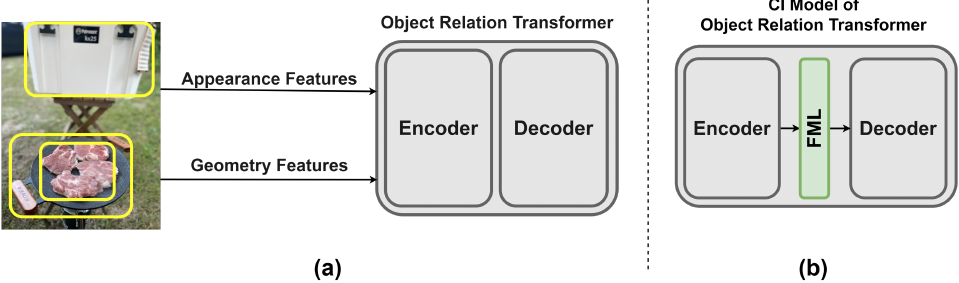
Figure 10. Object Relation Transformer (ORT) model architecture. ( a ) The ORT model devised a new encoder block to process image features and geometry features. ( b ) ORT model structure using FML to apply CI method. We used the Dense Layer 2